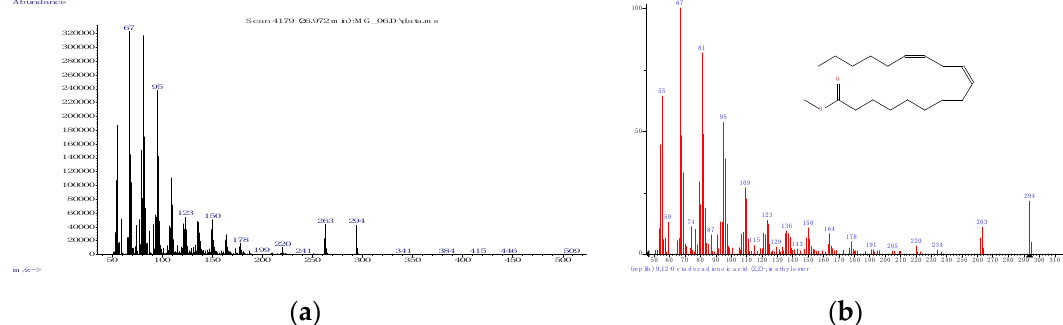
Figure 7. Experimental (left) and from the NIST 2011 database (right) mass spectra for the main fatty acids (as methyl esters) identified in the derivatized lipid fractions from Mangalitza hard fat—Polyunsaturated fatty acids (PUFAs): linoleic acid ( a , b ).